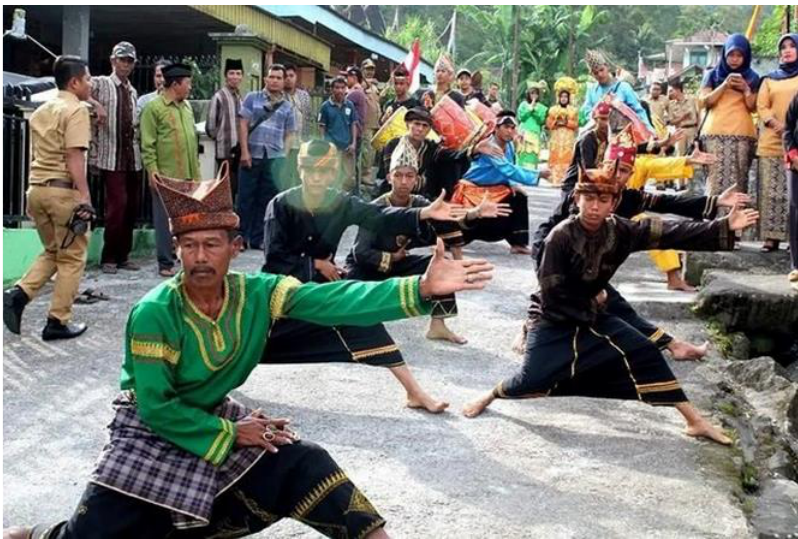
Fig. 4 Galombang Dance or Silek Dance, (Ediwar, 2022).